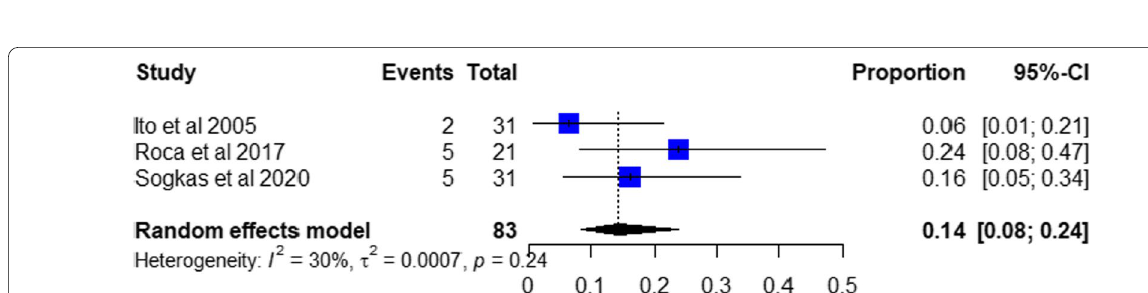
Fig. 9 Meta‑analysis of the Indeterminate pattern in patients with Sjogren’s